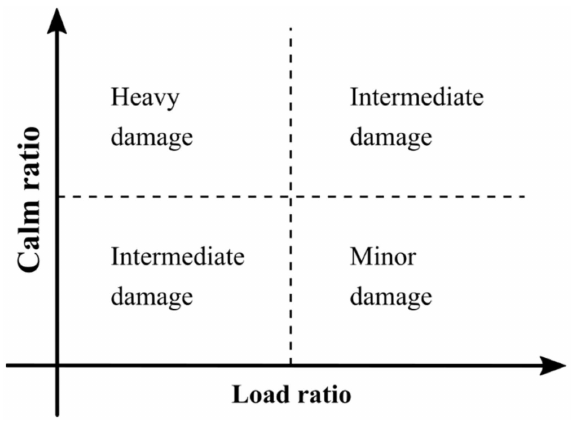
Figure 1. Damage classification by load and calm ratio